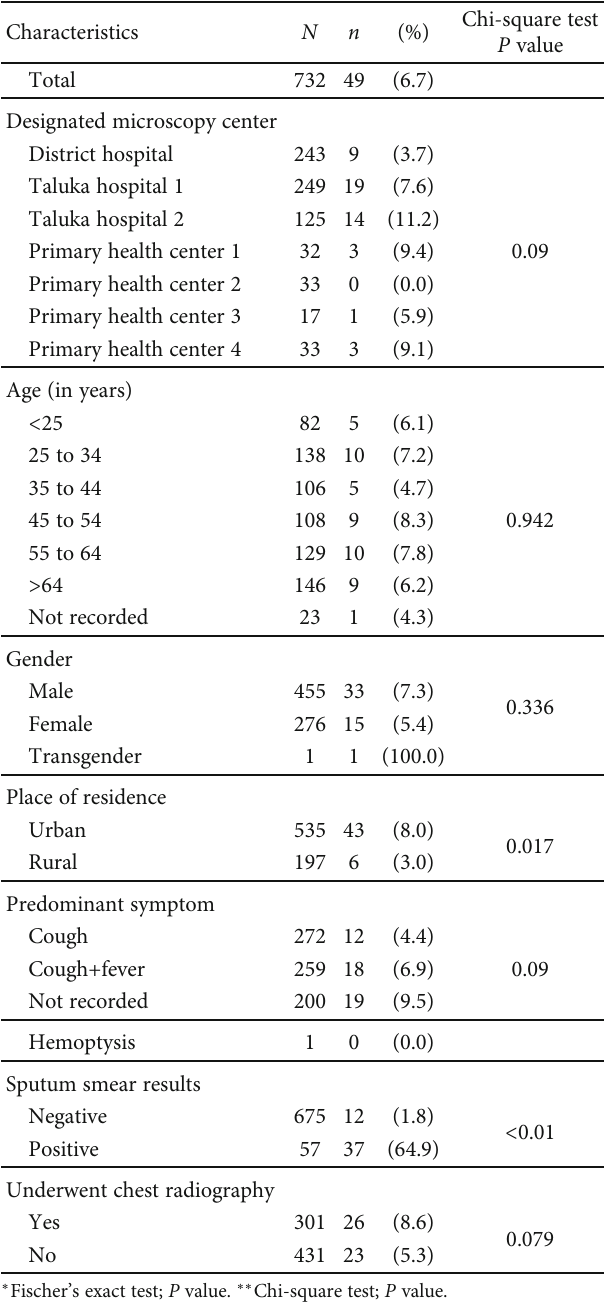
Table 3: Factors associated with CB-NAAT in presumptive pulmonary TB enrolled for sputum smear examination in seven selected designated microscopy centers in Chikkaballapur District during February-March